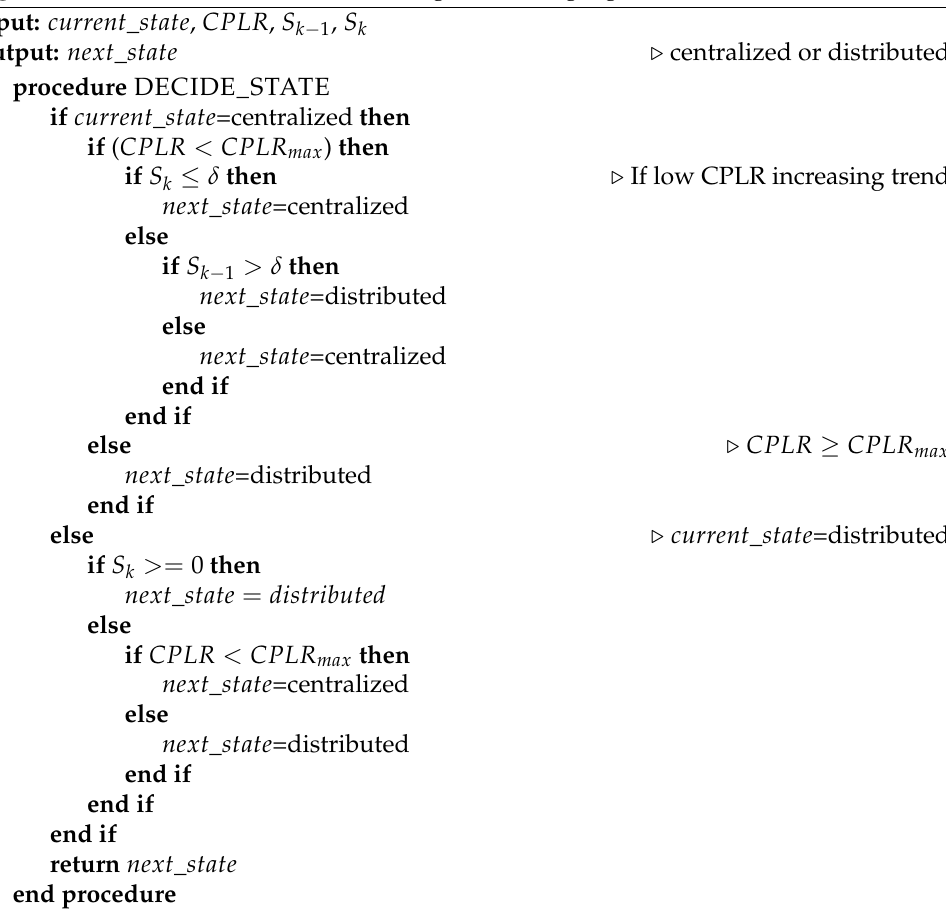
Algorithm 1 Pseudo code of the control logic switching